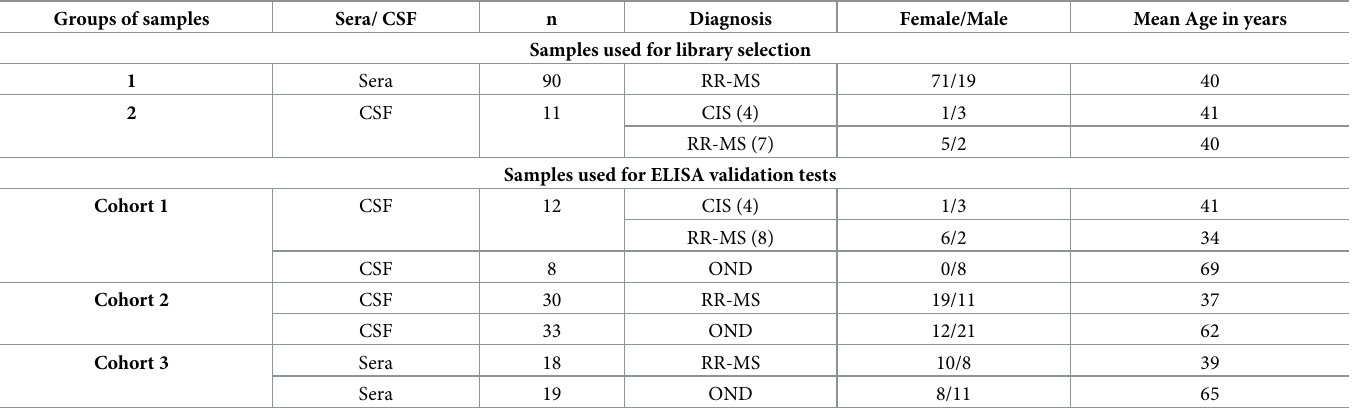
Data of the groups of patients samples: for each group the source (sera or CSF), the number (n), the diagnosis (RR-MS, CIS or OND), the sex ratio and the mean age of the samples are